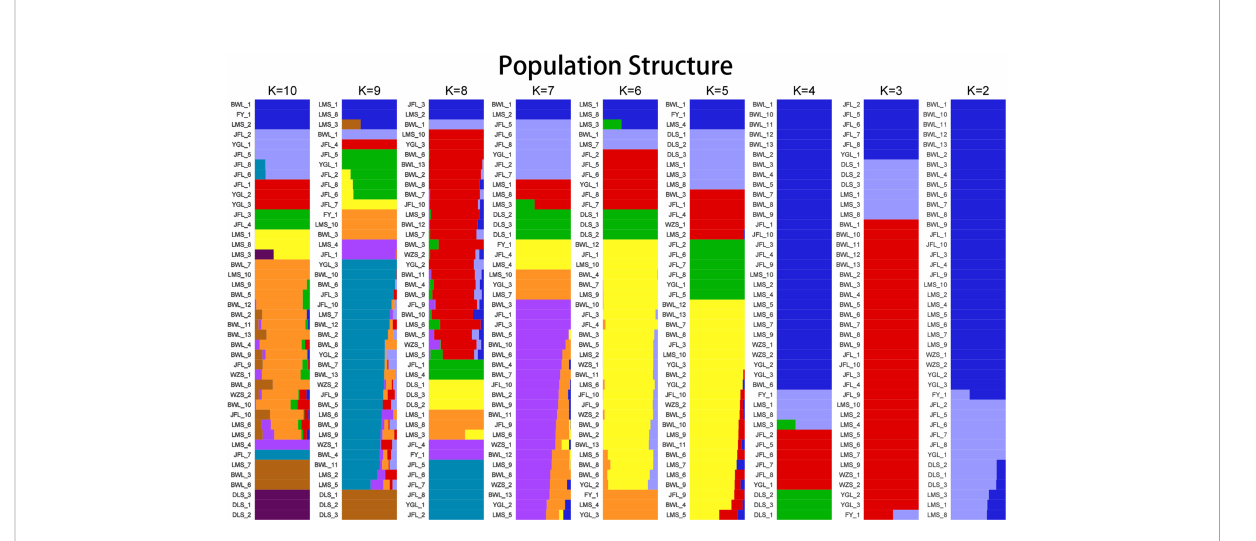
FIGURE 3 The population structure analysis on Hopea hainanensis.